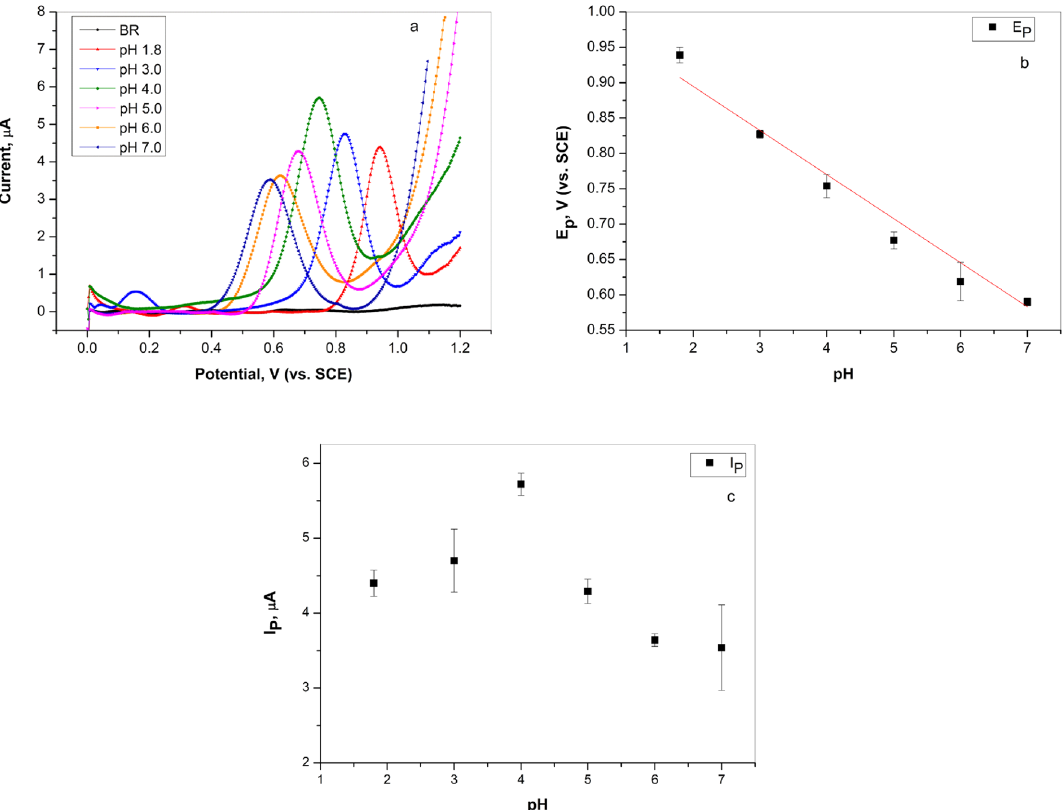
Figure 2. ( a ) Differential pulse voltammetry curves of 100.0 µM L-tryptophan on graphite electrode in Britton– Robinson buffer solution at different pH values, scan rate 50.0 mV/s (curves subjected to baseline correction); ( b ) Dependence of the peak potential of 100.0 µM L-tryptophan on pH value of the Britton–Robinson buffer solution; ( c ) Dependence of current peak of 100.0 µM L-tryptophan on pH value of the Britton–Robinson buffer